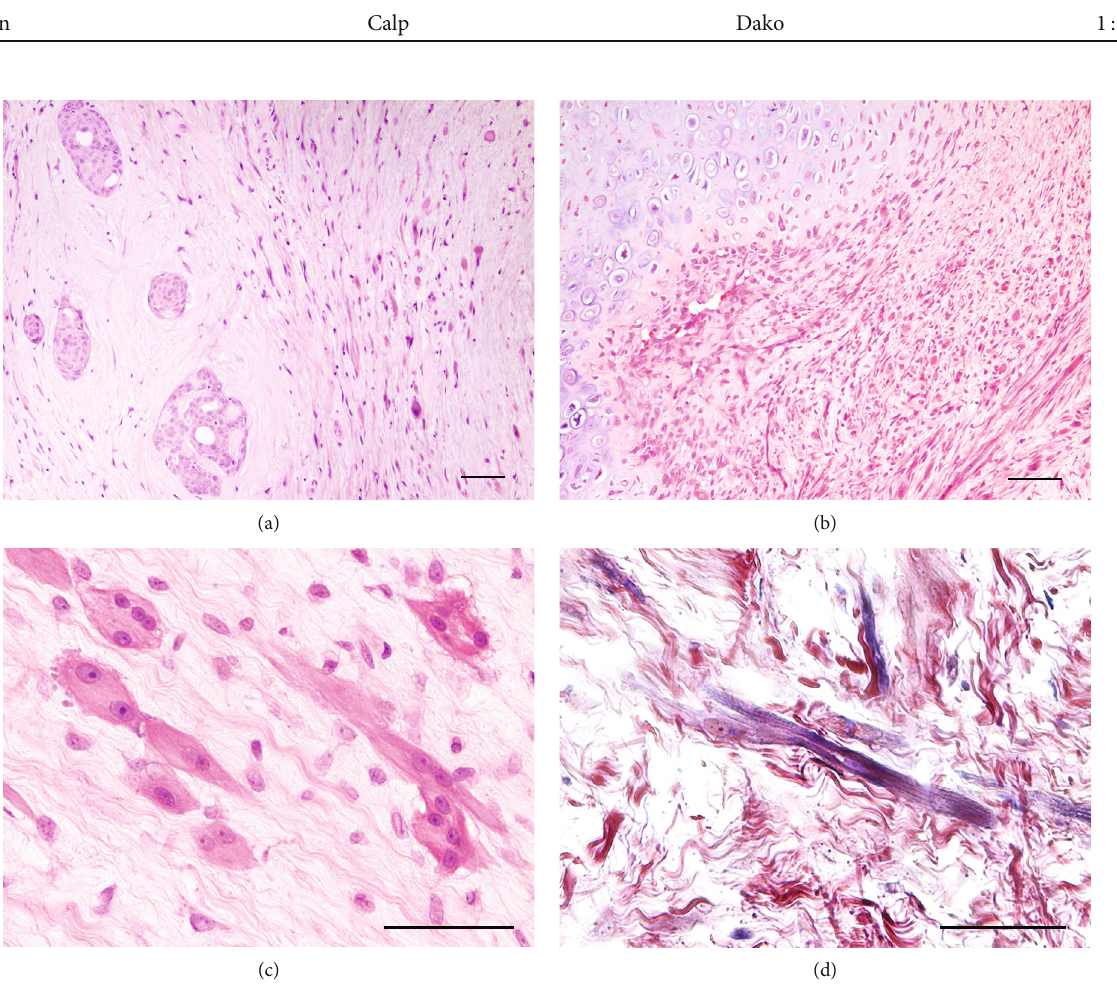
Figure 1: (a) Tubules of epithelial cells without feature of atypia (left) and scattered myoid spindle cells (right), HE, 10x, scale bar 100 micron. (b) Lobules of hyaline cartilage with well-di ff erentiated chondrocytes, surrounded by a moderate cellular population of elongated myoid cells embedded in a moderate amount of myxoid extracellular matrix, HE, 10x, scale bar 100 micron. (c) Giant spindle multinucleate cells, 50-70 micron, with abundant eosinophilic cytoplasm and cross striation (strap-like cells or rhabdomyoblasts), HE, 40x, scale bar 100 micron. (d) Striated muscles are highlighted in blue, with prominent cross striations, PTAH, 40x, scale bar 100